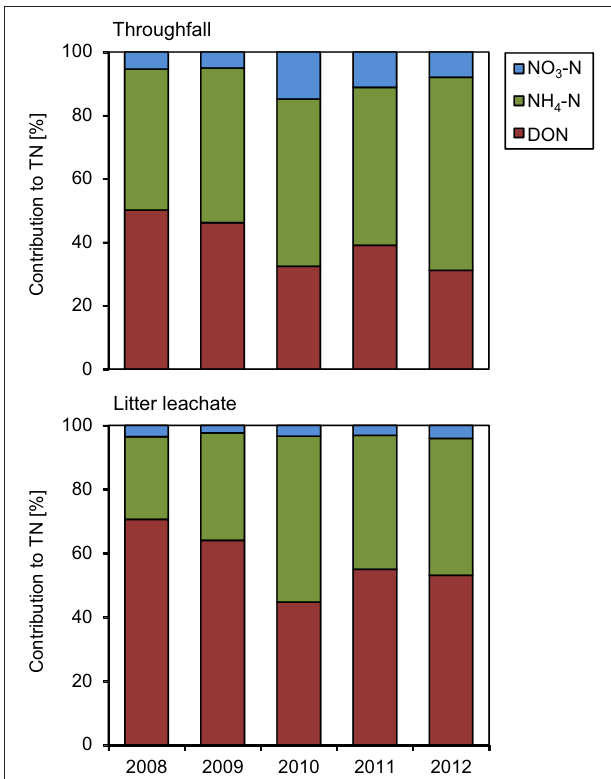
FIGURE 7 | Contributions to total nitrogen (TN) in throughfall and litter leachate between 2008 and 2012. The diagrams show the individual contributions of dissolved organic nitrogen (DON), ammonium-N (NH 4 -N), and nitrate-N (NO 3 -N) to total nitrogen (TN) in the control plots of the nutrient manipulation experiment